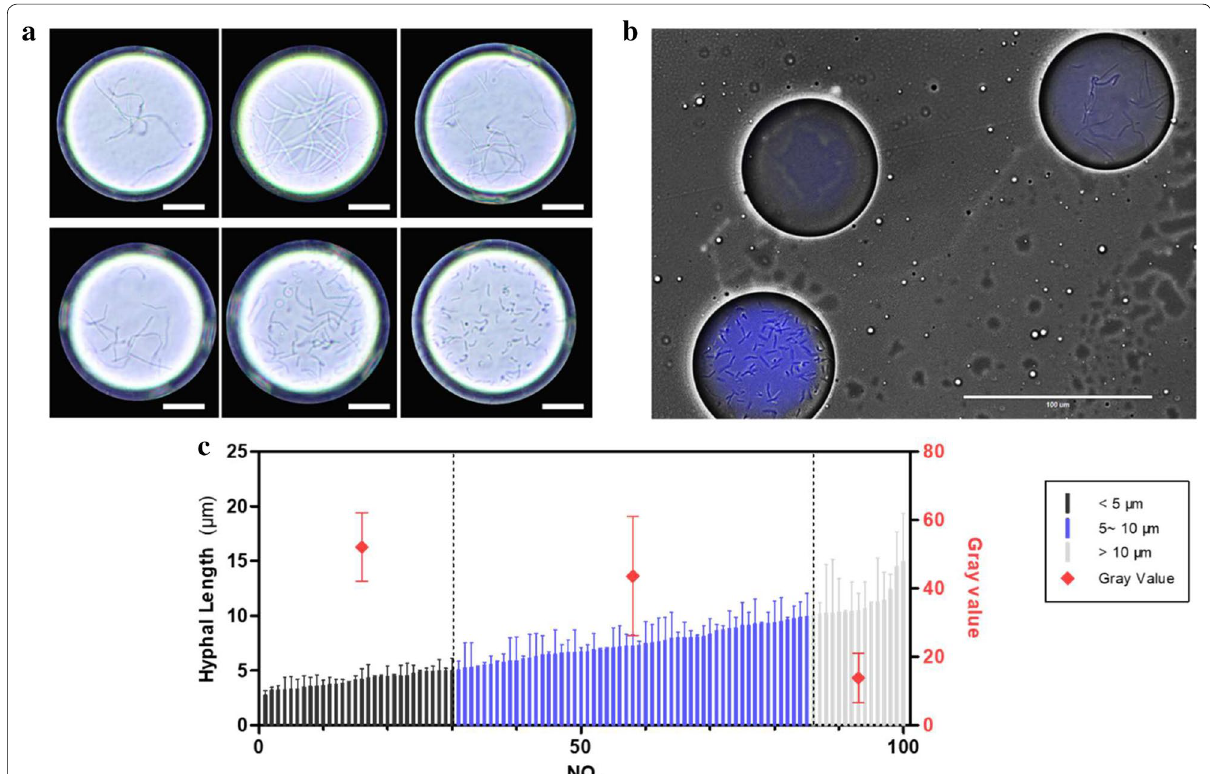
Fig. 5 Morphological heterogeneity of B. coagulans derived from a single colony. a There was a significant difference in hypha length. Scale bar: 20 μm. b The shorter B. coagulans cells (lower left corner) produced more lactic acid than the longer cells (top right corner). Scale bar: 100 μm. c Relationship between the hyphal length and lactic acid productivity of B. coagulans . The length of the hyphae in one droplet is shown in the columns, representing the average length of five randomly selected hyphae in a given droplet. The square symbol for each group is the average gray value for all the droplets in the group. The results show that the shorter B. coagulans cells produced more lactic acid than the longer